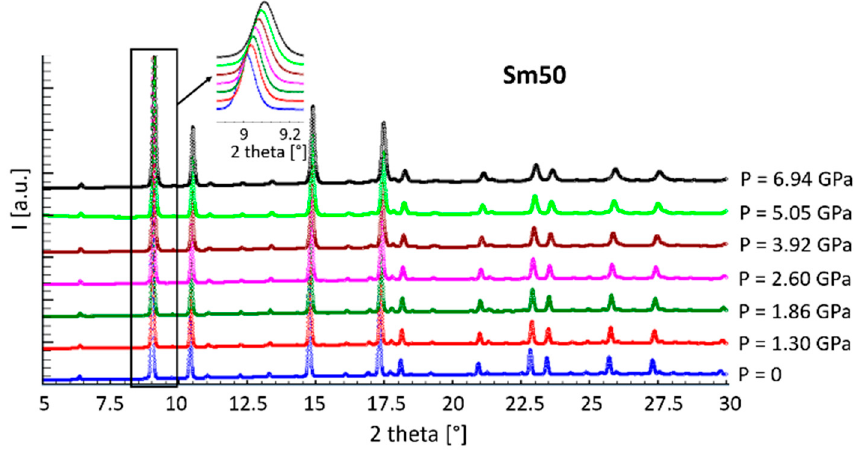
Figure 4. Di ff raction patterns of sample Sm50 at all pressure Figure 4. Diffraction patterns of sample Sm50 at all pressure values.